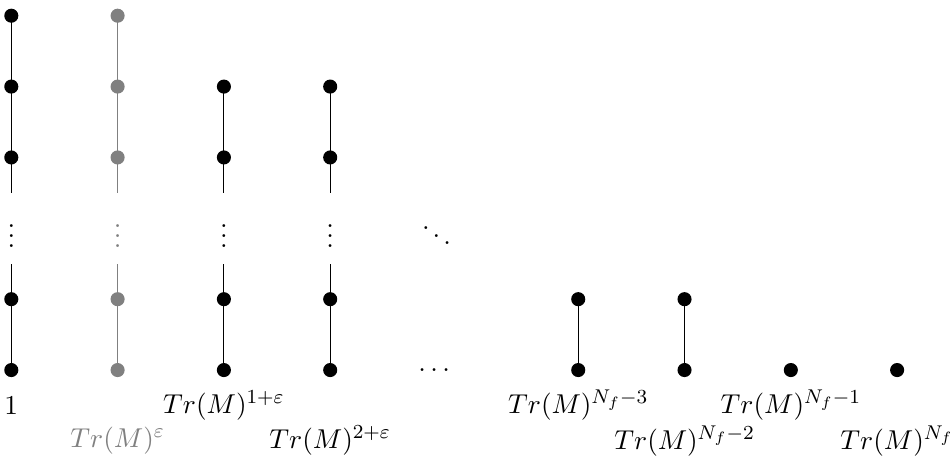
Figure 22 . Conjectured stratification of the Hilbert series of pure mesonic Higgs branches, the grey is present if N f is odd. Again ε = 0 if N f is even and ε = 1 if N f is odd.